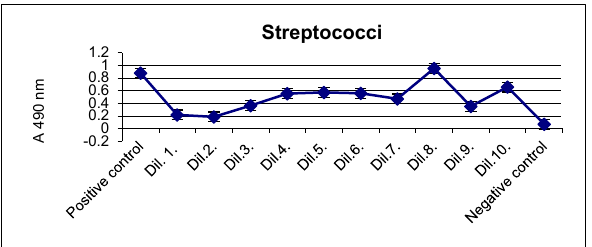
Figure 3. Graphic representation of the inhibition of microbial biofilms developed on the inert substratum in the presence of binary concentrations of the 1/6000 silver-nitrate stock solution for the analyzed strains (Dil.1.–10.-tested binary concentrations) (average value of absorbances obtained for the tested strains are represented).